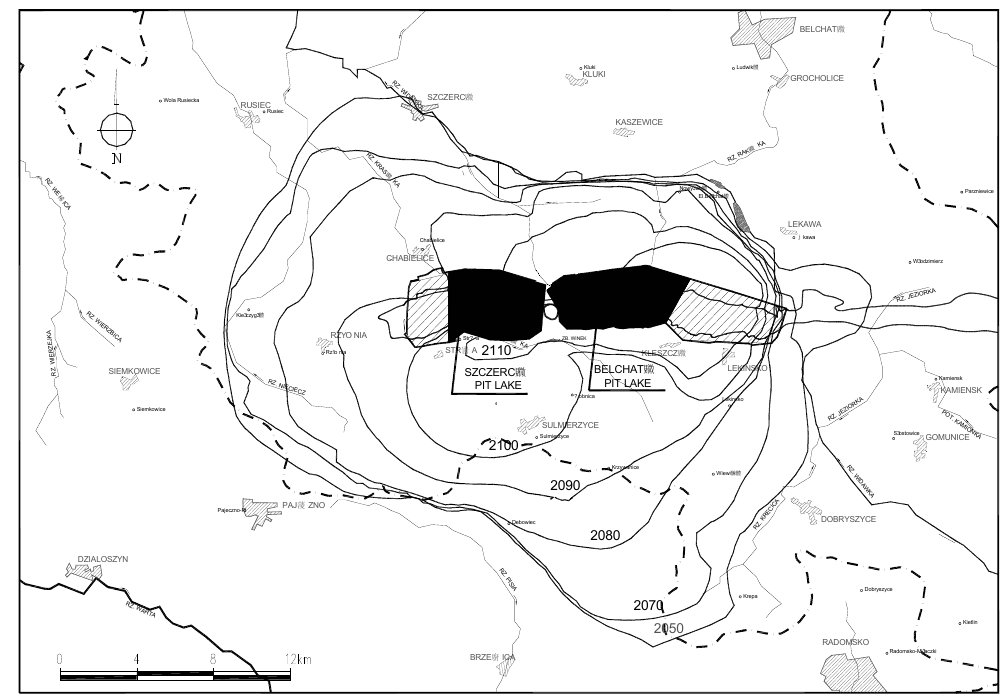
Figure 10. Proposed location of pit lakes in the Belchatow post-mining area with the cone of depression reduction, in case of no additional recharge [57].